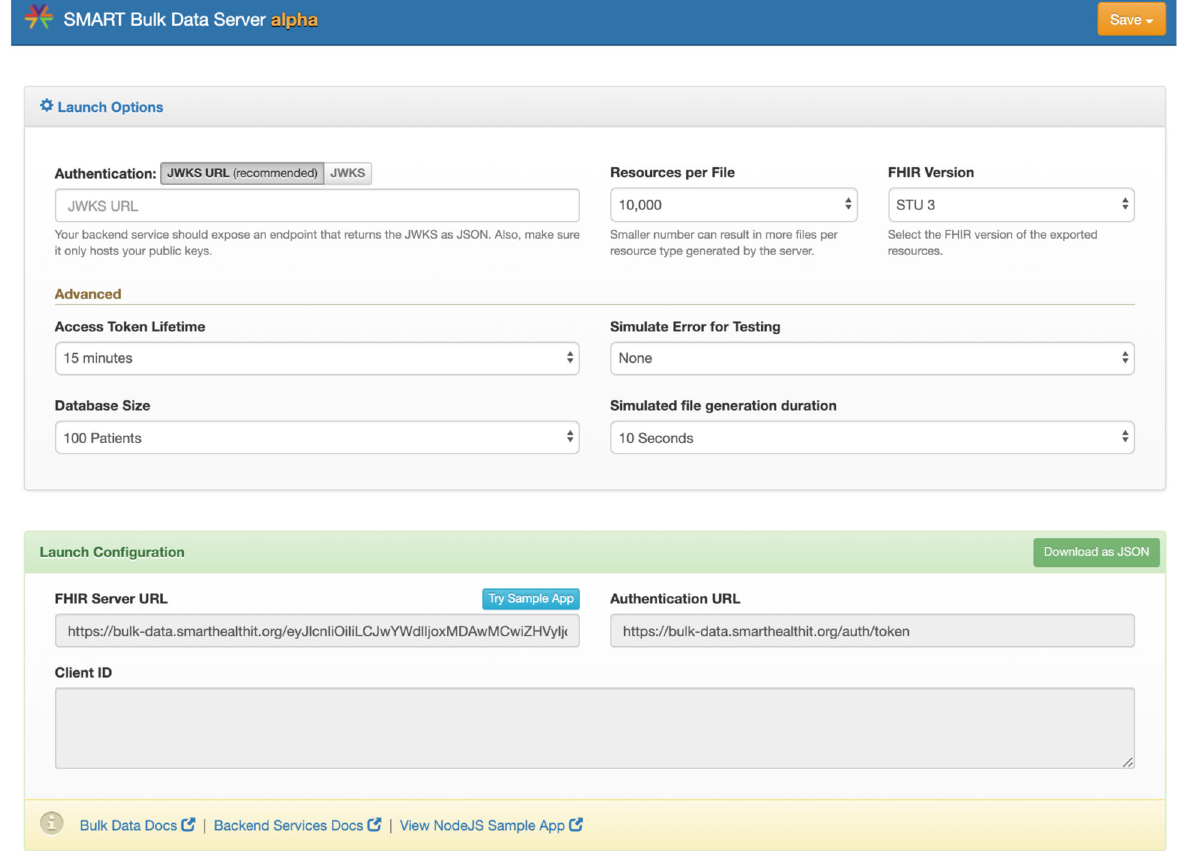
Fig. 3 SMART Bulk Data Server Reference Implementation. The open-source SMART Bulk Data Server implements the Bulk Data Access API and serves synthetic